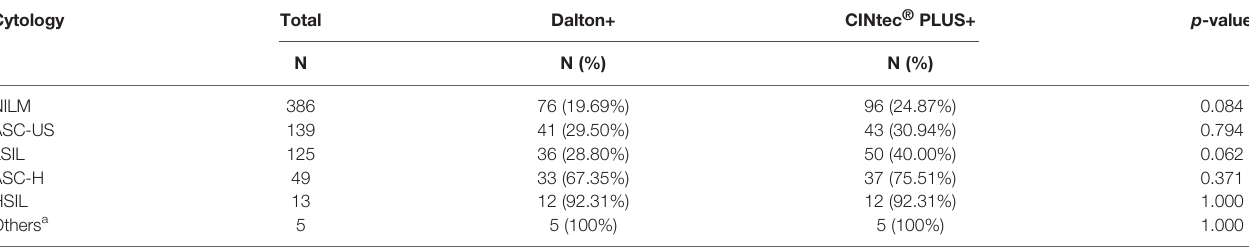
TABLE 2 | The positivity of Dalton and CINtec ® PLUS p16/Ki-67 Dual Stain in different cytology groups. Cytology Total Dalton+